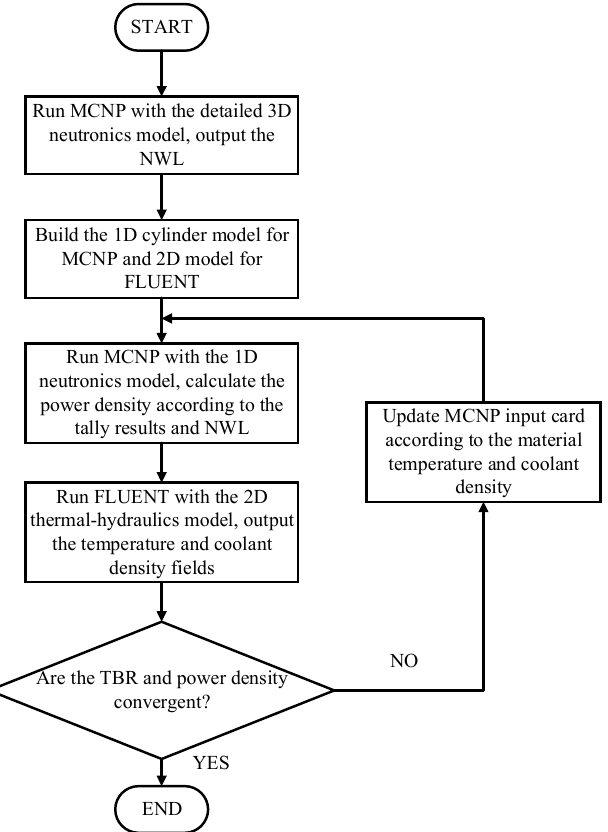
/ FLUENT coupling code